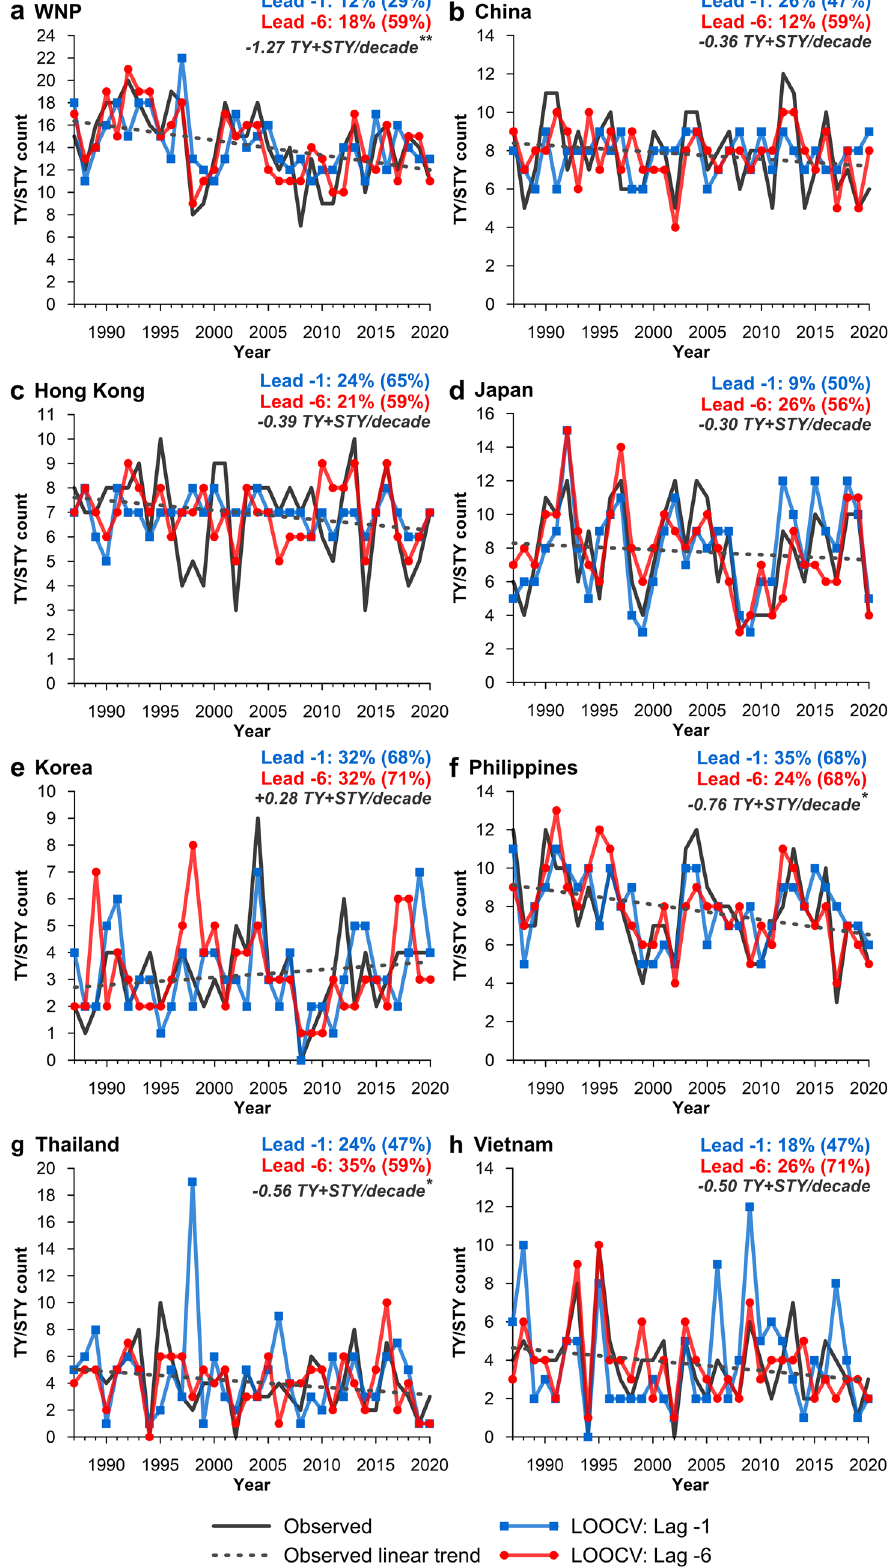
Figure 6. Comparison of observed and LOOCV predicted typhoons (TY and STY events) between 1987 and 2020. The LOOCV prediction is compared for two pre-season periods: lead − 1 (1 month before the start of the typhoon season; blue line) and lead − 6 (6 months before the start of the typhoon season; red line). On-panel percentage values indicate LOOCV SR-E (SR+ − 1 in parentheses) for models lead − 1 and lead − 6. Dashed line represents observed linear trend with on-panel trend (/decade) summarised in grey italics with statistical significance (Mann–Kendall test) denoted by an asterisk (*significant at 90% confidence level; **significant at 95% confidence level; ***significant at 99% confidence